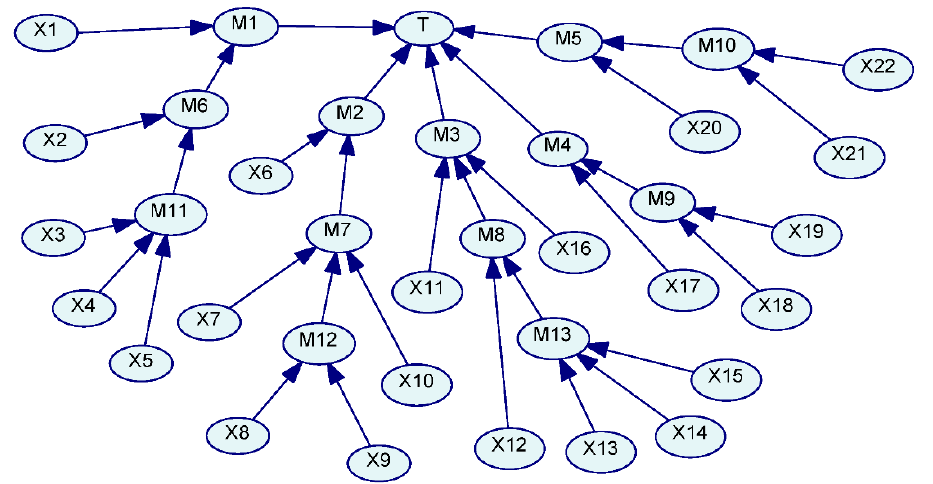
Figure 4. Bayesian network of hydraulic support failure.